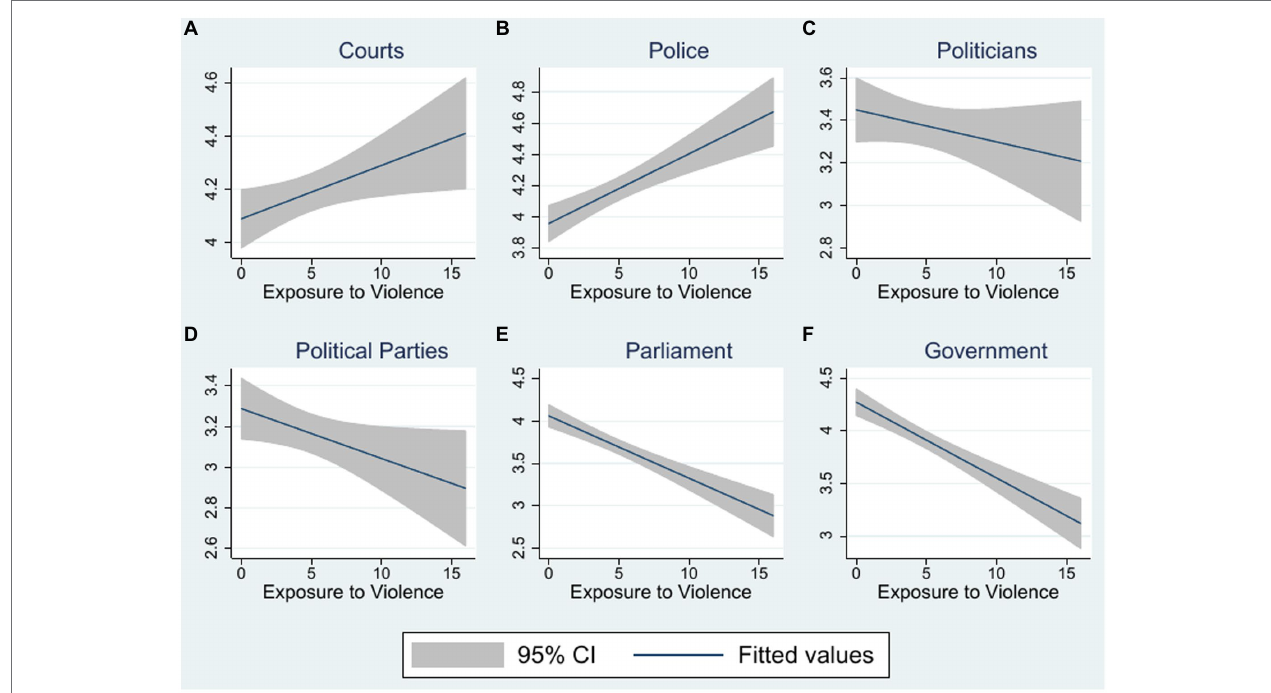
FIGURE 3 | Relationship between exposure to violence and institutional